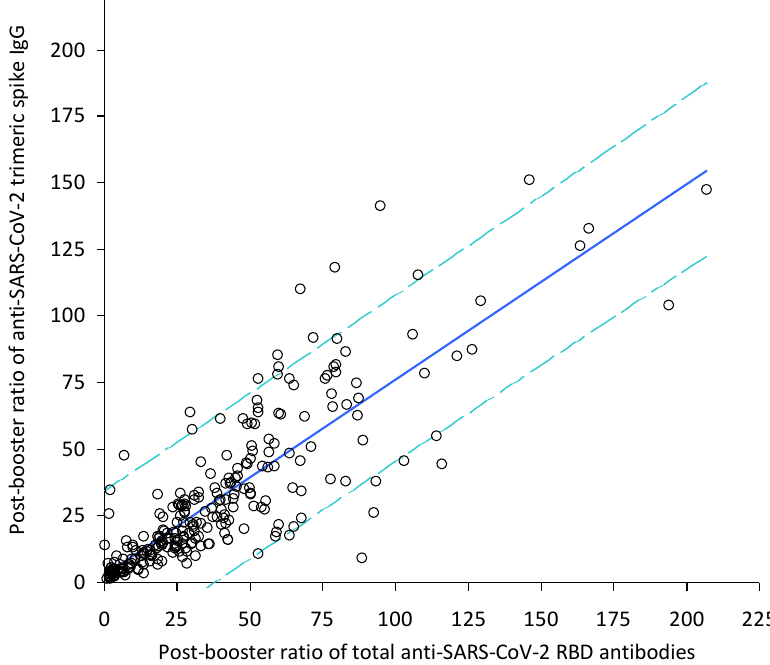
Figure 1. Correlation between relative increase (i.e., ratio of BNT162b2 post-booster and pre-booster serum values) of anti-SARS-CoV-2 total antibodies and anti-SARS-CoV-2 spike trimeric IgG.